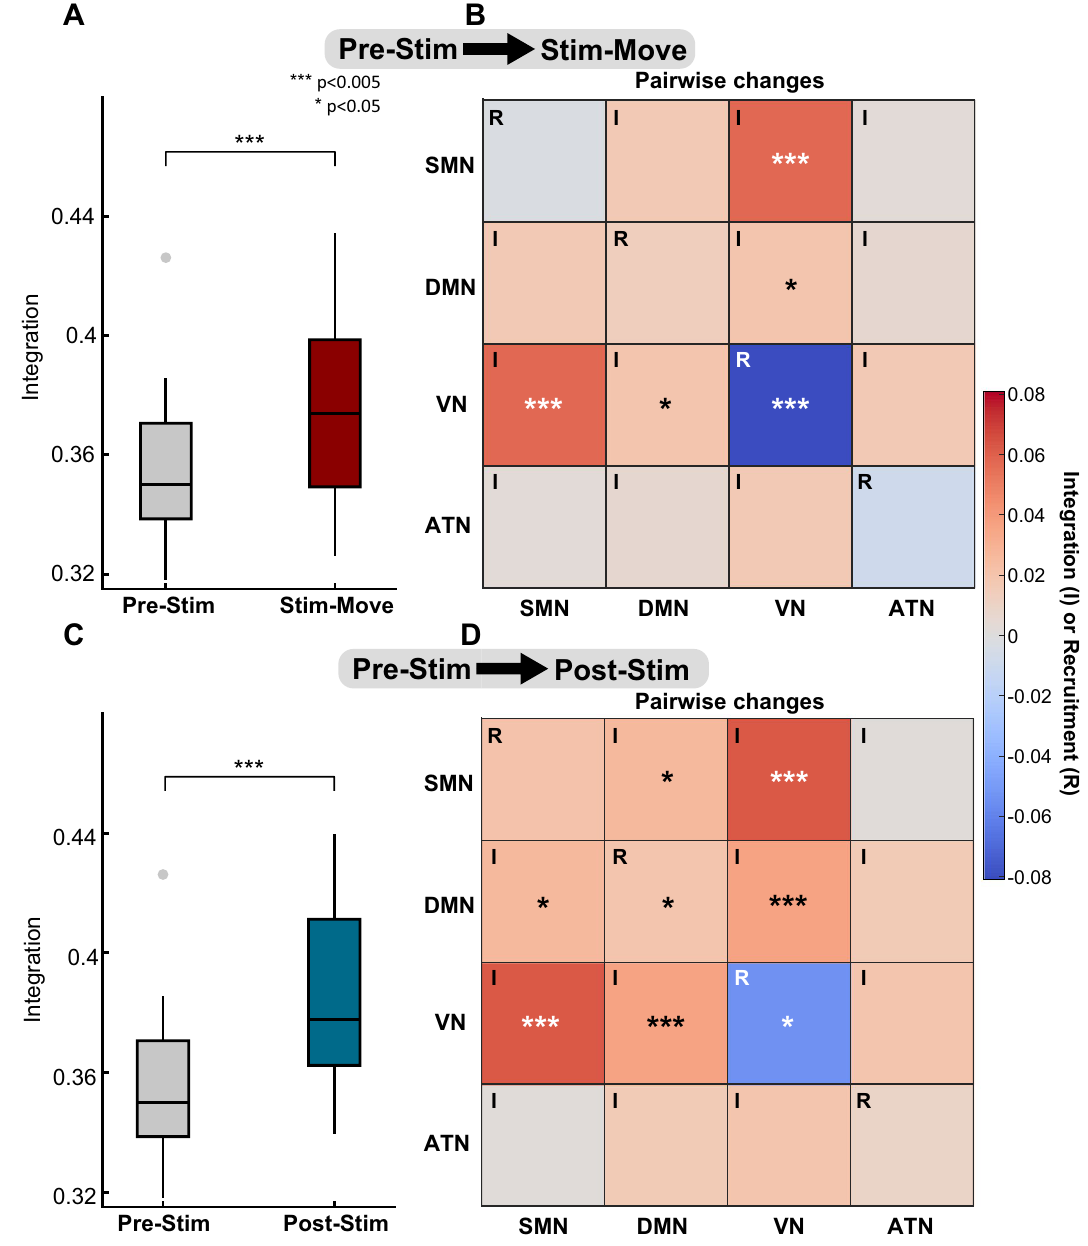
Figure 6. Changes in integration and recruitment of large-scale systems for participant A01. ( A ) Overall integration increased with statistical significance comparing Stim-Move with Pre-Stim. ( B ) Pairwise changes in integration and recruitment of the four large-scale systems (SMN, DMN, VN, and ATN) show statistically significance increase in integration between SMN and VN, and DMN and VN during Stim-Move. Recruitment of VN decreases. ( C ) Comparing Post-Stim with Pre-Stim, overall integration increased. ( D ) Integration increased between SMN and DMN, SMN and VN, and DMN and VN. Recruitment increased for DMN and decreased for VN. ( A ), ( C ) n = 30 each box. ( B ), ( D ) Each square plots the average absolute change in integration (I) or recruitment (R) compared to Pre-Stim. Matrix plots are symmetric across the diagonal. All marked statistical significance was false discovery rate (FDR) corrected expect for VN-DMN integration in ( B ). See Supplementary Table S3 for statistical power